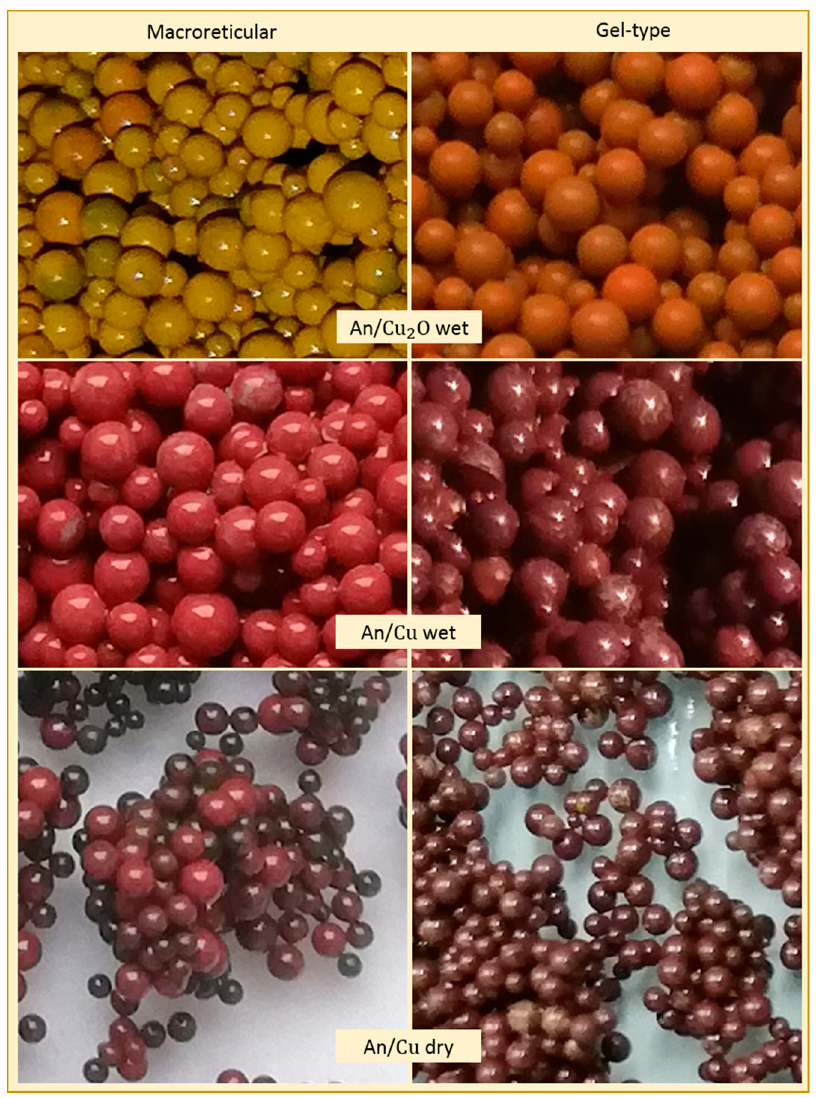
Figure 6. Photographs of examined materials: based on macroporous anion exchanger (left column) and gel-type anion exchanger (right column).